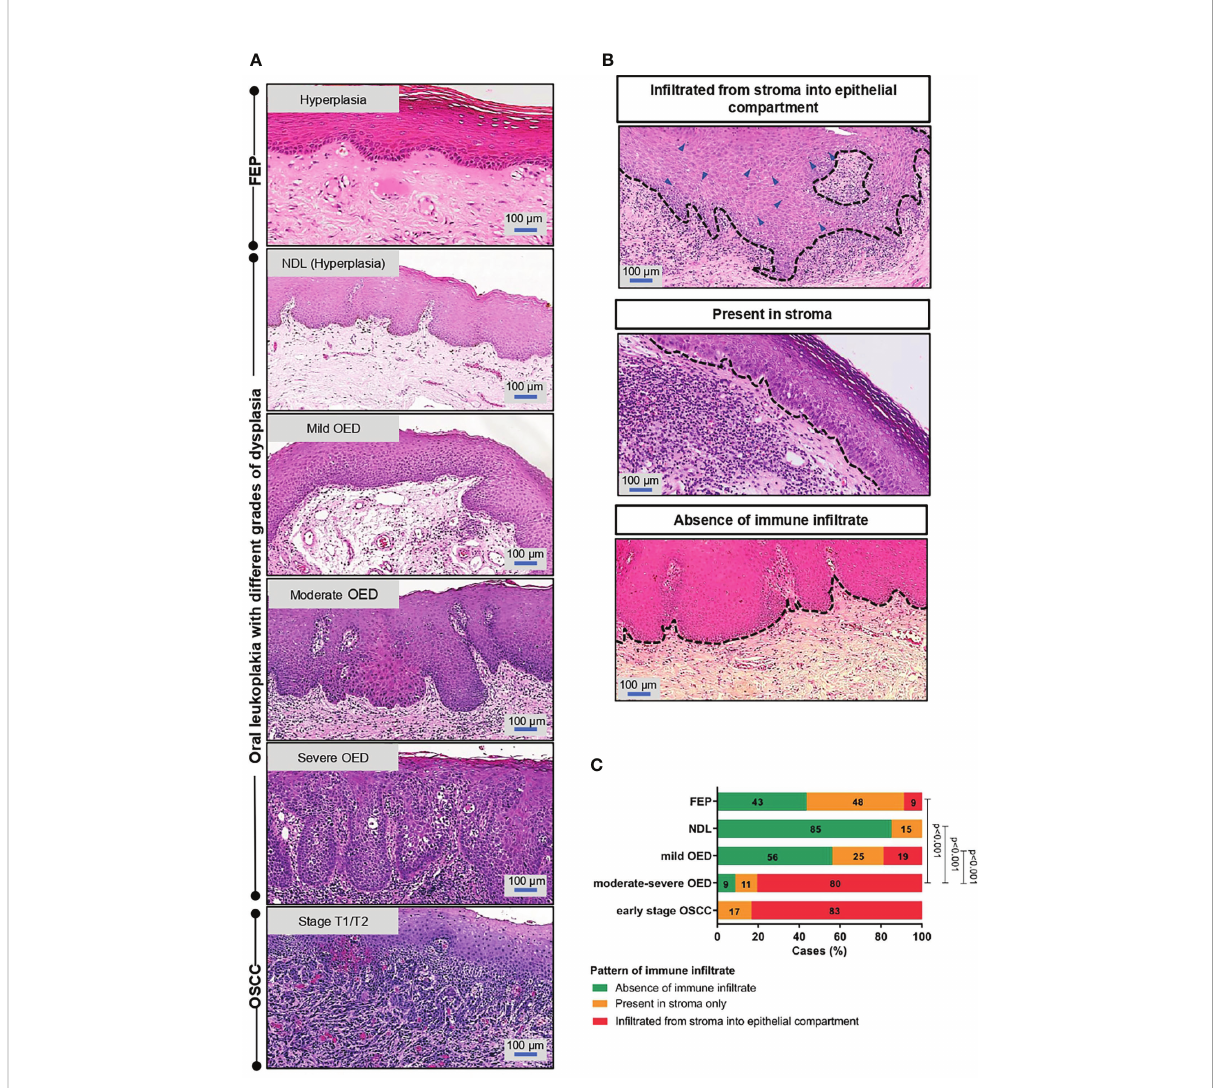
FIGURE 1 Immune in fi ltrate pattern is associated with the severity of OED. (A) Histopathological images depicting the changes of epithelial architecture from benign lesions to OSCC. Fibroepithelial polyps (FEP) is a reactive benign hyperplastic lesion. OPMD examined in this study comprised of oral leukoplakia that were histologically diagnosed with either hyperplasia (NDL), mild, moderate and severe OED. Early stage OSCC were of pathological stage T1/T2. Both FEP and NDL are hyperplastic, hence were used as control in the respective experiment. (B) Representative microscopic images of immune in fi ltrate pattern observed in H&E-stained tissue section. The pattern of immune in fi ltrate was graded at the region of interest (ROI) and classi fi ed into 3 groups: (i) in fi ltrated from stroma into epithelial compartment (ii) present in stroma (iii) absence of lymphocytic in fi ltrate. (C) A signi fi cant proportion of moderate-severe OED demonstrated immune in fi ltrate from stroma into the epithelial compartment. 80% of moderate-severe OED and early stage OSCC showed immune in fi ltrate from stroma into the epithelial compartment compared to 9% of FEP. Chi-square test was performed to determine the association of immune in fi ltrate pattern with disease